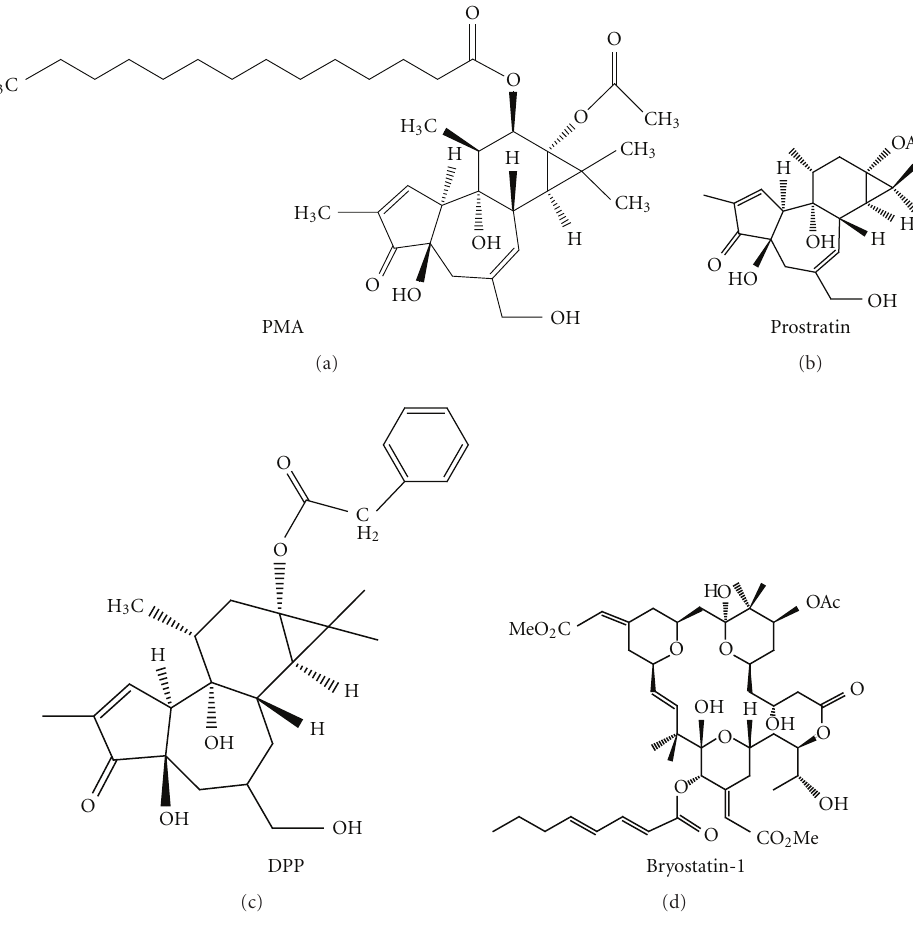
Figure 4: Comparative chemical structures of PKC-modulating